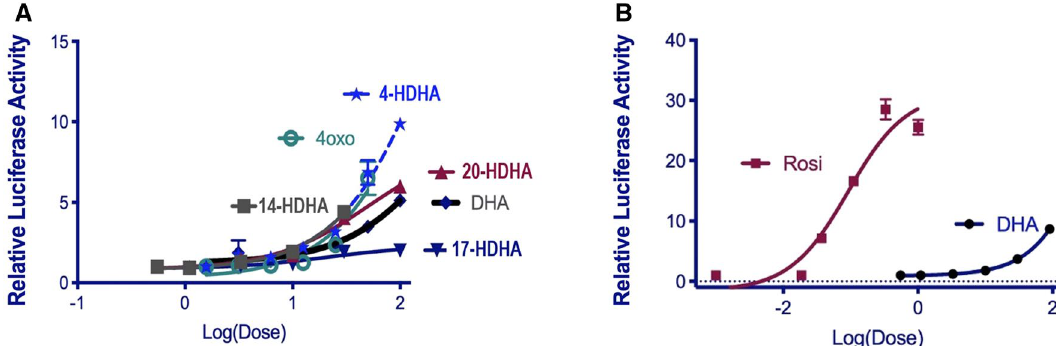
Figure 3. The effect of several ADM on PPAR ɣ activity. Human PPAR ɣ reporter cells were treated with various concentrations of ADM (0.5 to 100 μM final concentration in media, ( A ) or rosiglitazone (0.01 to 1 μM, [ B]) for 16 h. Data is derived from relative luciferase units (RLU) expressed relative to the vehicle control (DMSO, 0.1% v/v). Data represents mean ± SEM, n = 4, representative of at least two independent